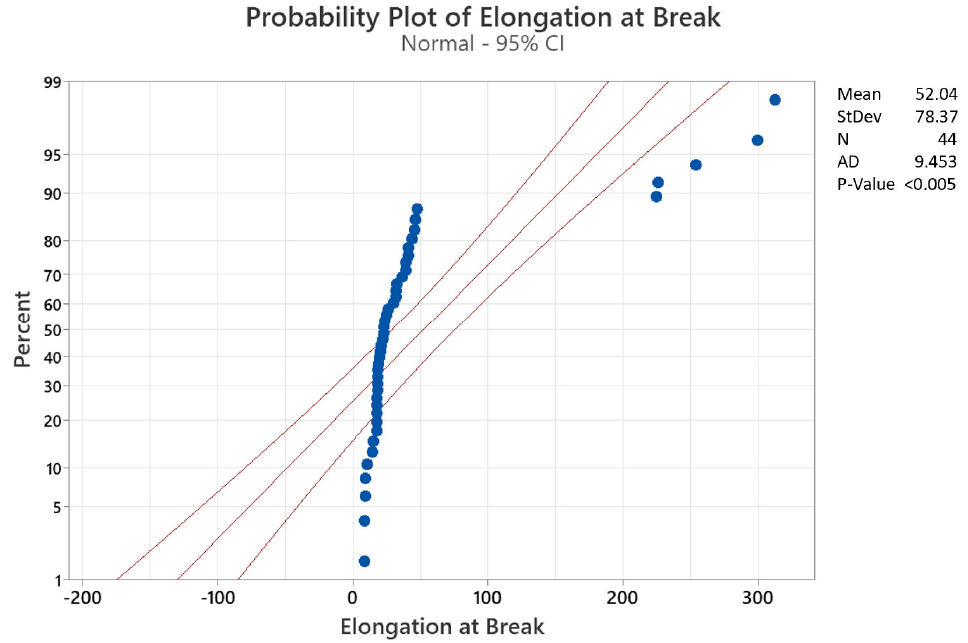
Figure 11. Normal distribution probability plot for elongation at break.